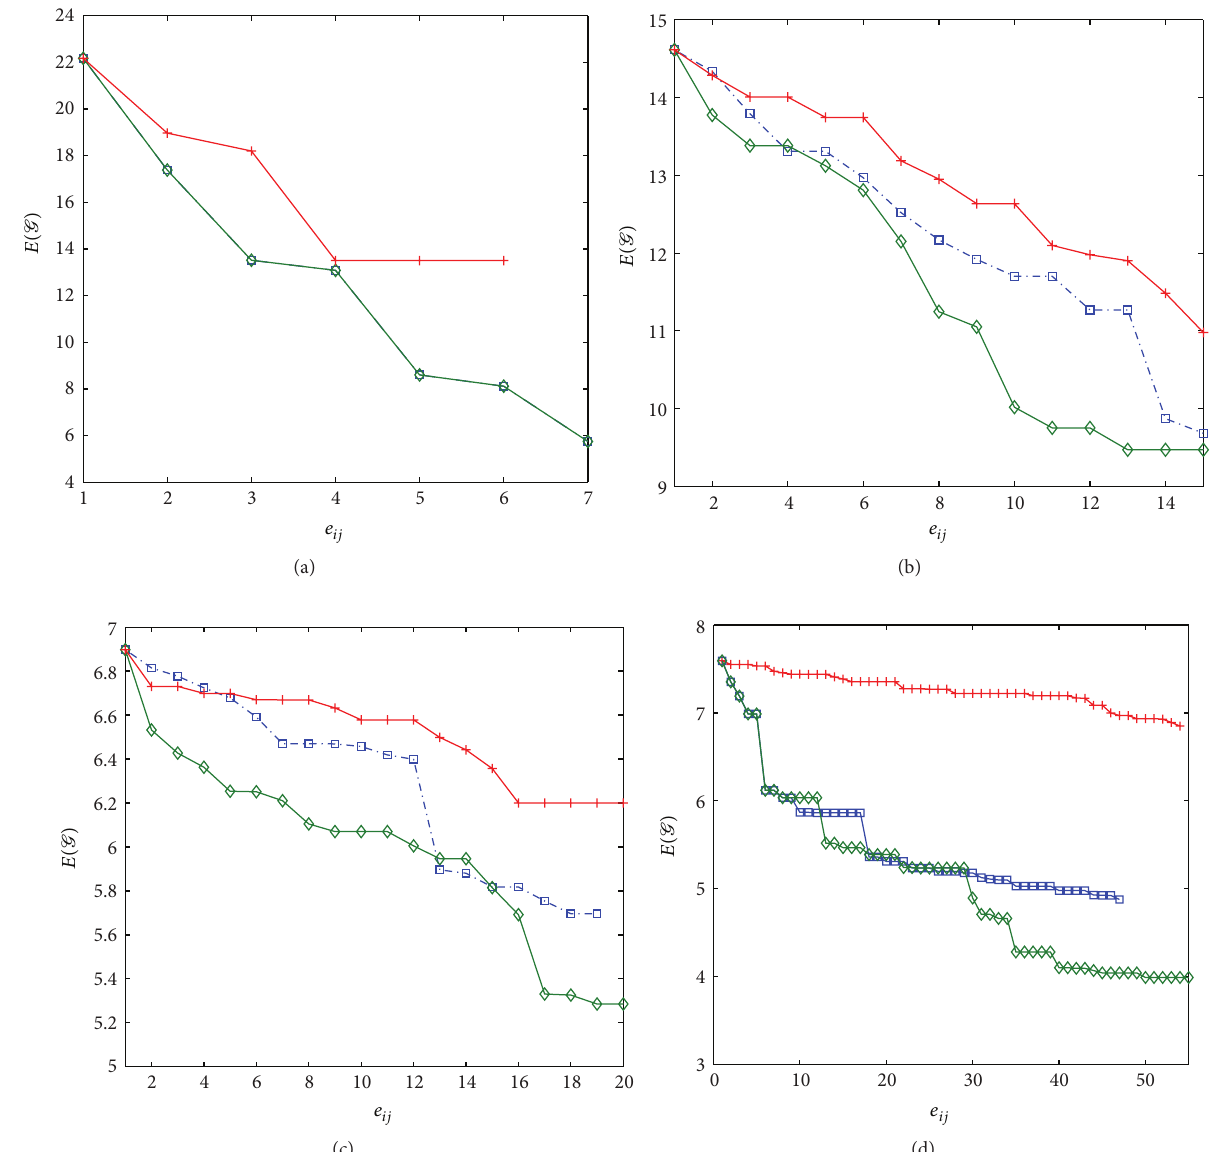
Figure 10: Global efficiency of (a) G 4 , (b) G 16 , (c) G 48 , and (d) G 50 under random (—+—) and targeted attacks (— ⋅◻⋅ — closeness and — ⬦ — betweenness